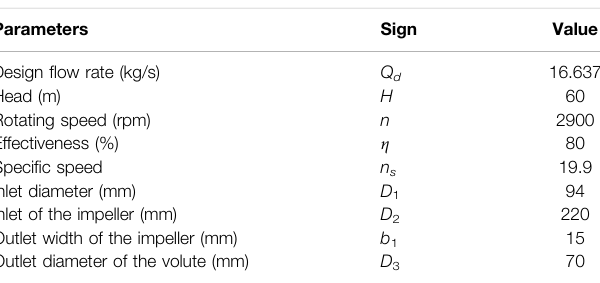
TABLE 1 | Main design parameters of the centrifugal pump.